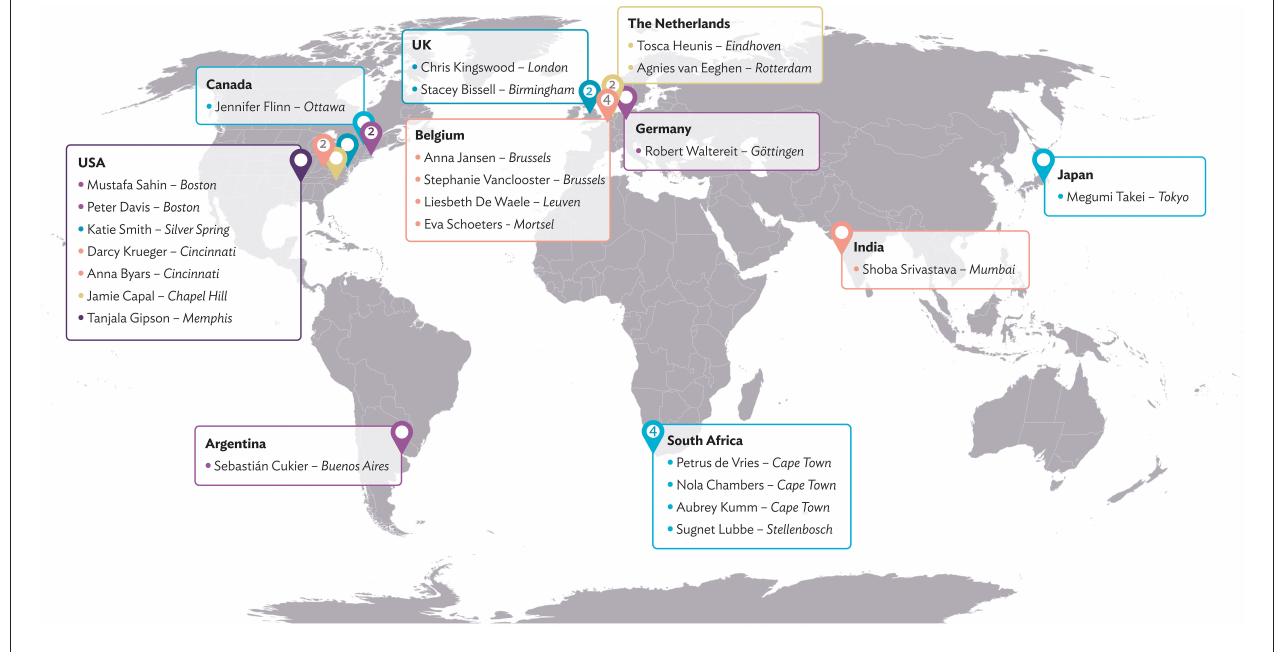
FIGURE 2 | TAND consortium.